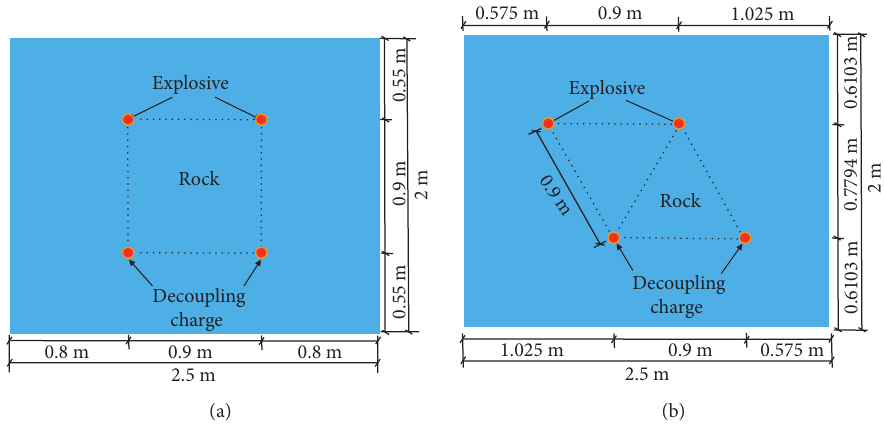
Figure 6: Analysis models with different blast-hole arrangements. (a) Rectangle. (b) Triangle.